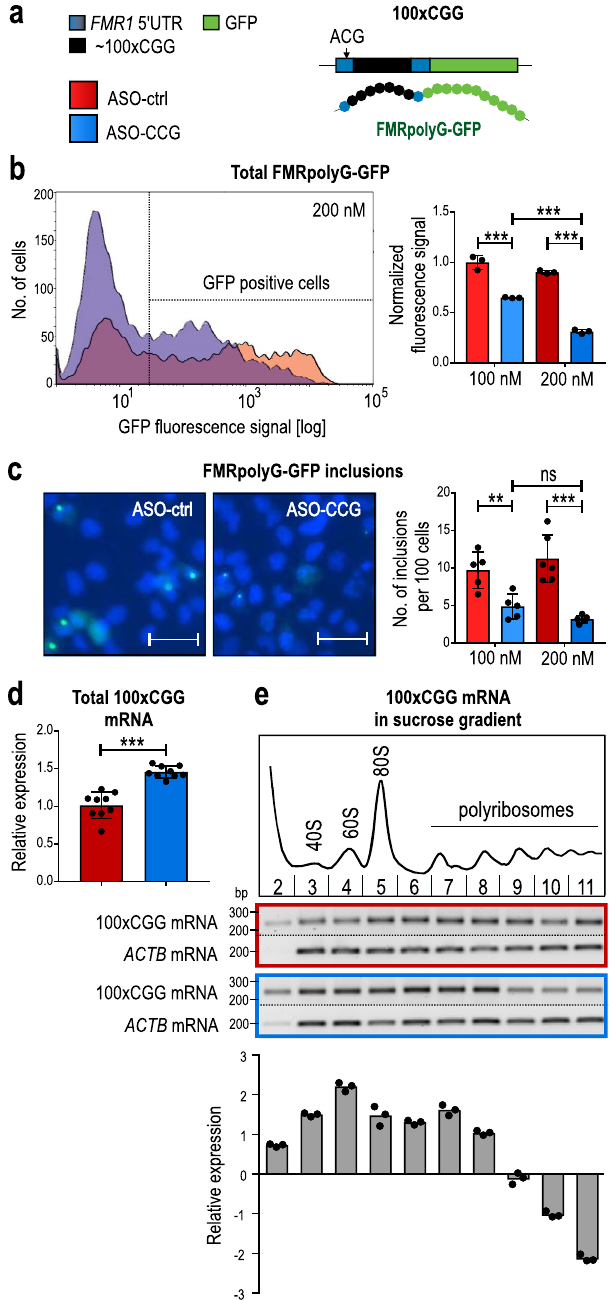
Fig. 2 The effect of ASO – CCG on FMRpolyG biosynthesis and aggregation. a Schematic of the 100×CGG genetic construct. This construct contains the 5 ′ UTR of the FMR1 gene (blue bars) with ~100 CGG repeats (black bar) fused with the GFP coding sequence (green